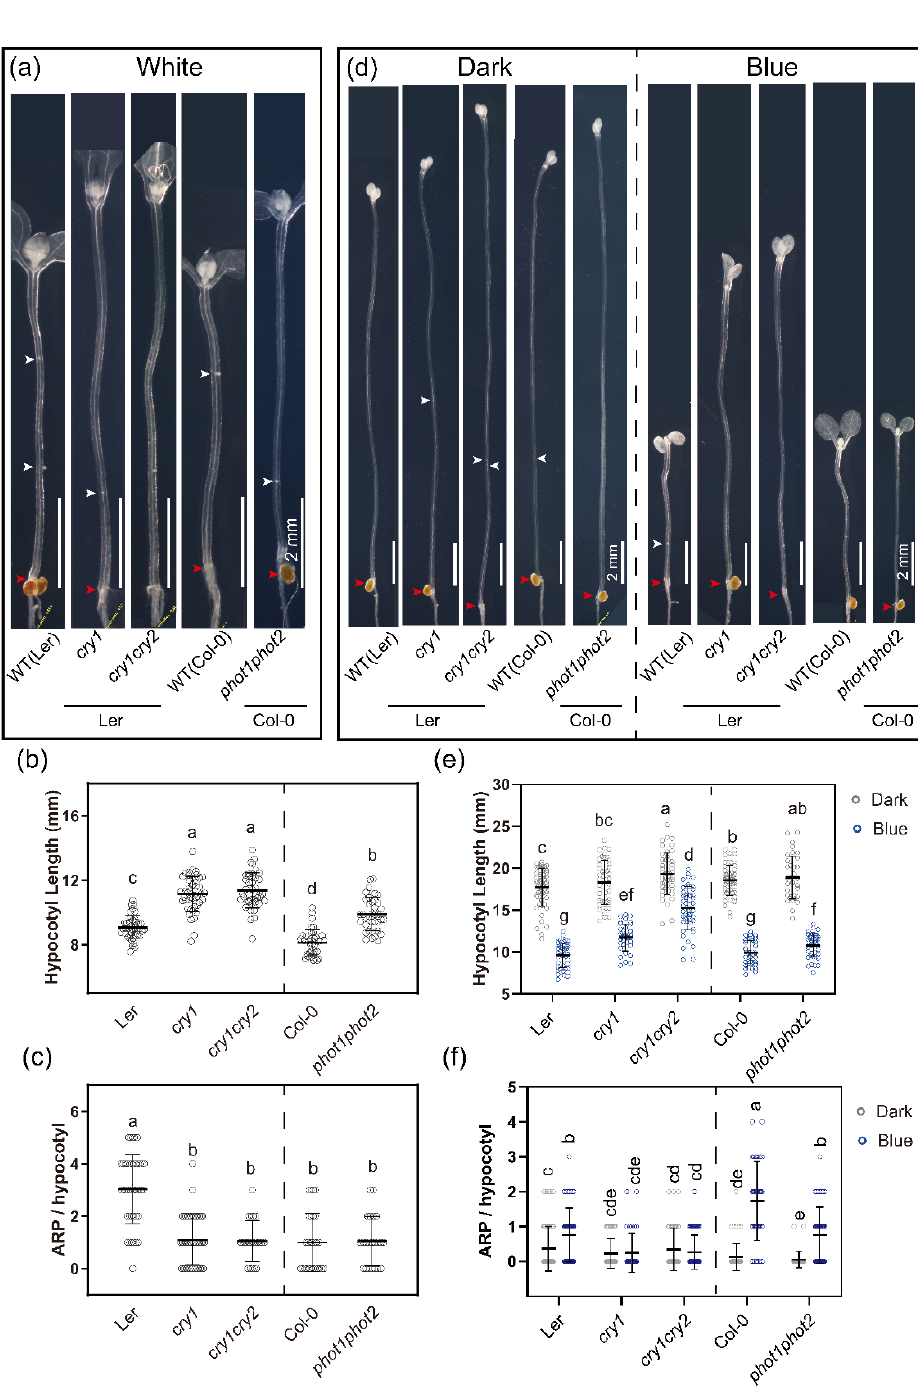
Figure 3. Blue light photoreceptors promote adventitious root induction. ( a ) Representative images of WT (Ler), cry1 (Ler), cry1cry2 (Ler), WT (Col-0) and phot1phot2 (Col-0) cleared hypocotyls grown in white light for 4 days after 3 days etiolation. Scale bar: 2 mm. ( b , c ) Quantification of the ( b ) hypocotyl length and ( c ) ARP of seedlings as in ( a ). ( d ) Representative hypocotyl images of three-day-old etiolated seedlings illuminated with blue light for 4 days. White arrowheads indicate ARPs, the red arrowhead points to the hypocotyl root junction. ( e , f ) Quantification of the ( e ) hypocotyl length and ( f ) number of ARP. The data in b and c (Ler, n = 40; cry1 , n = 45; cry1cry2 , n = 42; Col-0, n = 37; phot1phot2, n = 37 ), and in e and f (Ler, n = 60, 50; cry1 , n = 44, 36; cry1cry2 , n = 46, 52; Col-0, n = 56, 38; phot1phot2, n = 35, 45 for dark and blue light, respectively) represent mean values ± SD. Different letters indicate a significant difference at p ≤ 0.05 (ANOVA and LSD post hoc analysis). Scale bars in all pictures = 2 mm.